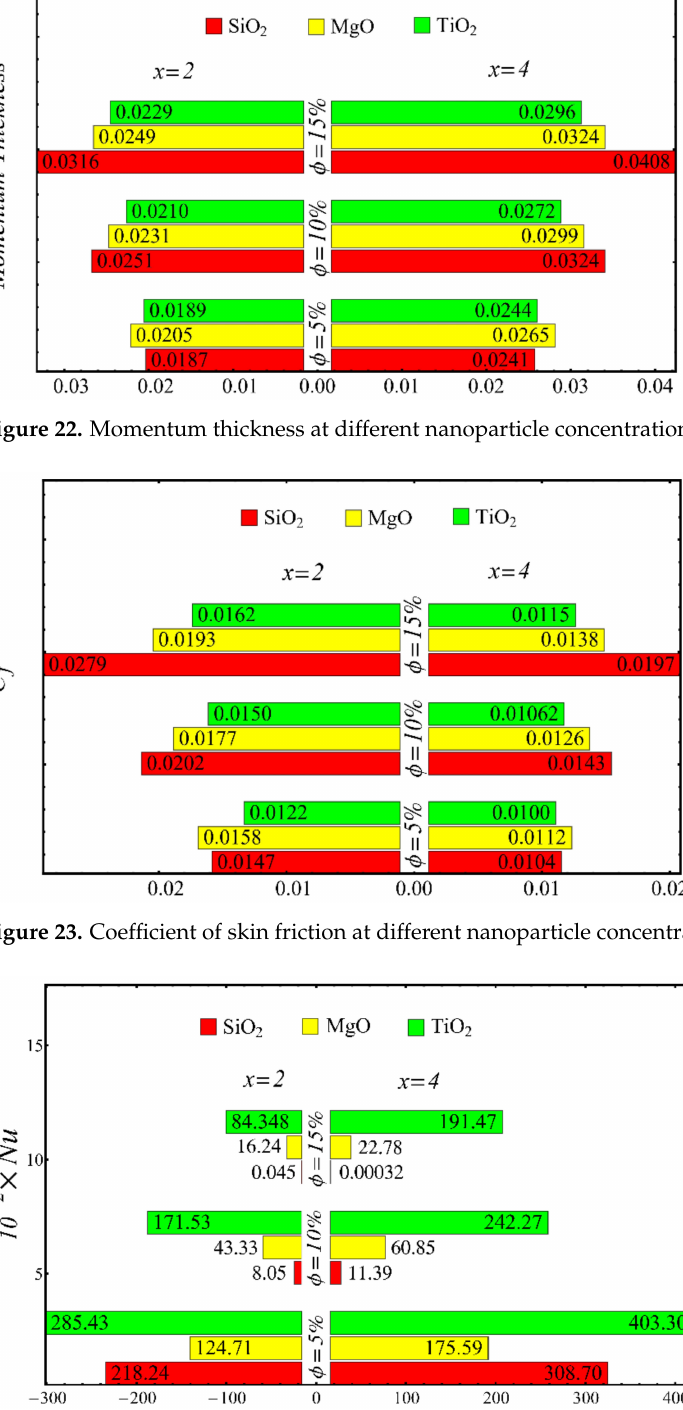
Figure 24. Nusselt number at different nanoparticle